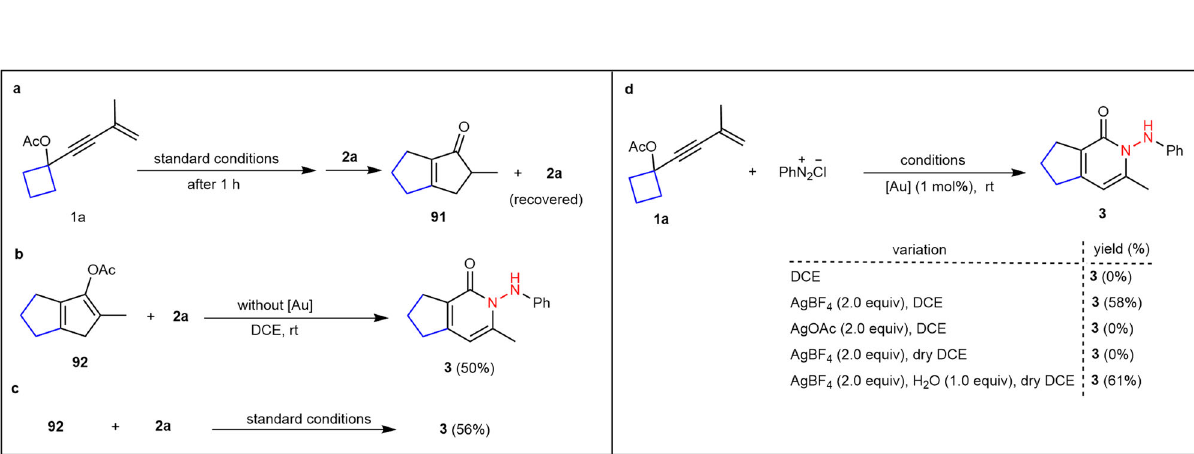
Fig. 6 |Preliminarymechanisminvestigations.a Two-step reactionof 1a with 2a . b Metal-freereactionof 92 with 2a . c The roleofthegold catalyst in theSchmidt-type reaction. d Investigations on the roles of tetra fl uoroborate anion and H 2 O for Schmidt-type